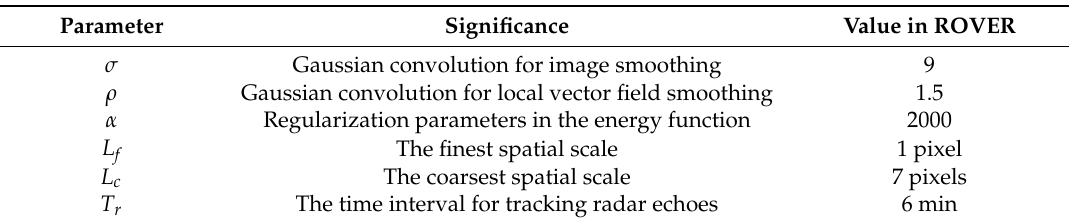
Table 2. Optical flow parameters adopted in